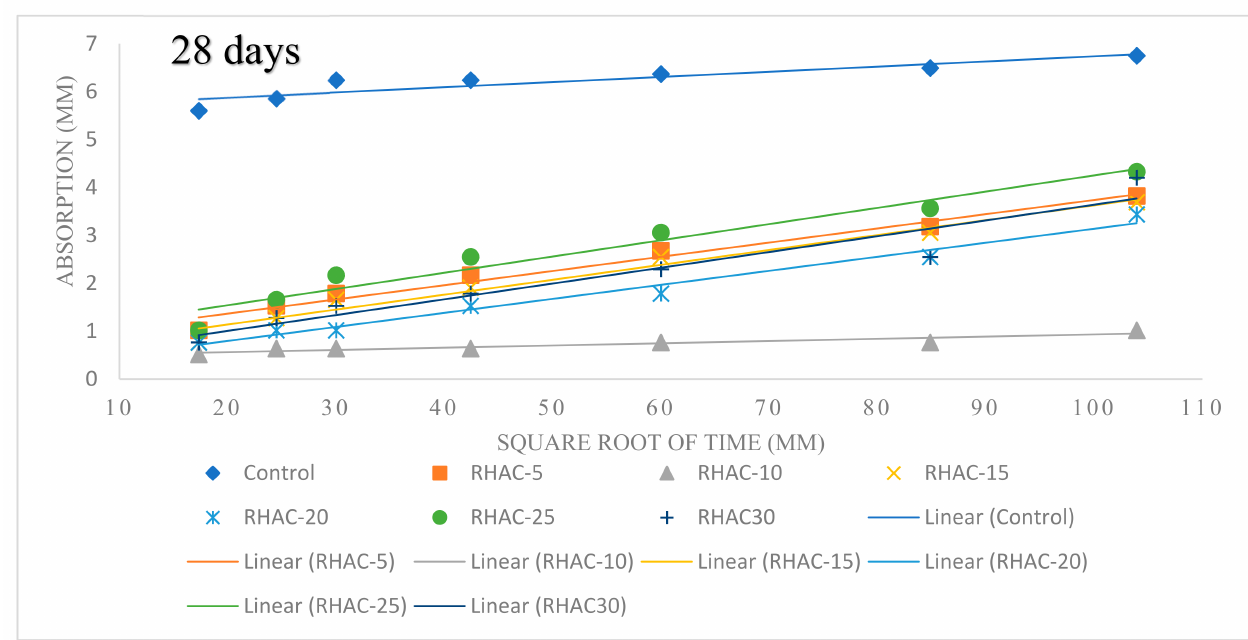
Figure 11. Sorptivity characteristics of HPCs with RHA for 28